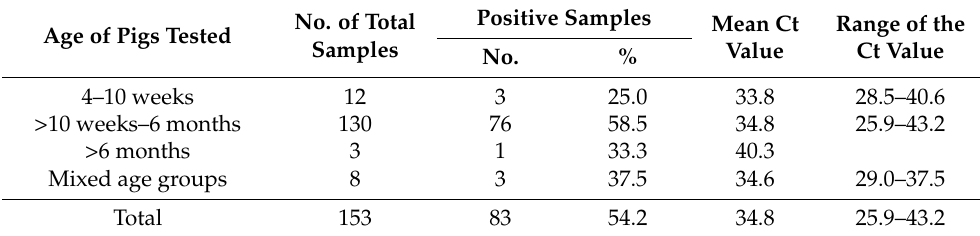
Table 2. Results of the HEV RT-qPCR from the sock swab screening.